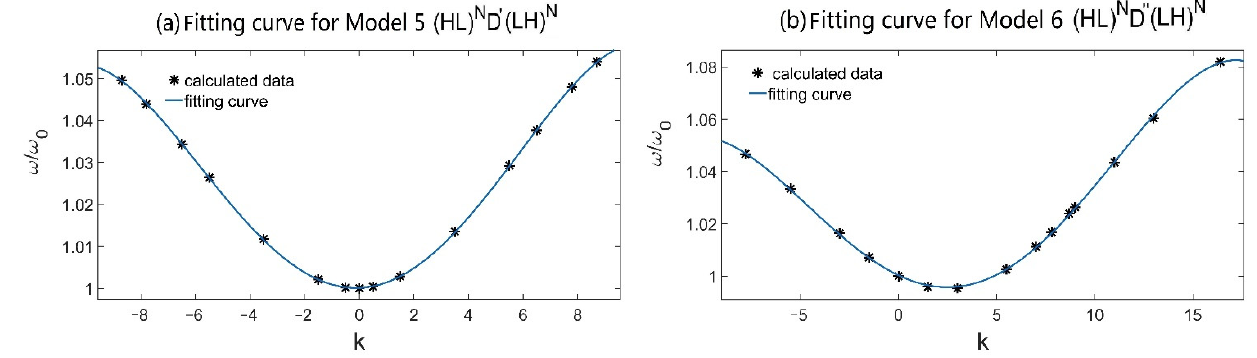
Figure 11. The fitting curves for frequencies of defect modes and slopes k of the gradient defects at incident angle θ = 0 ◦ for ( a ) Model 5 ( HL ) N D (cid:48) ( LH ) N and ( b ) Model 6 ( HL ) N D (cid:48)(cid:48) ( LH ) N .